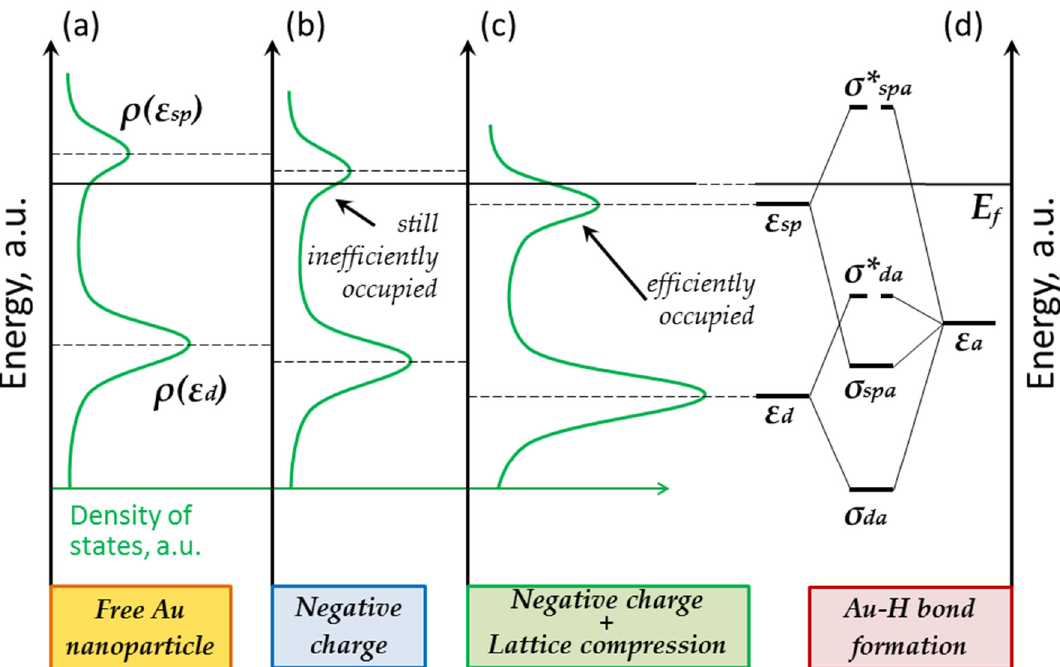
Figure 4. Influence of charge and deformation factors on the occupation of the surface sp-state and d-band state: ( a ) unsupported gold nanoparticle; ( b ) negatively charged gold nanoparticle; ( c ) gold nanoparticle with negative excessive charge and compressed atomic lattice; ( d ) formation of bonding and antibonding orbitals due to the interaction of adatom with sp-state and d-band state.